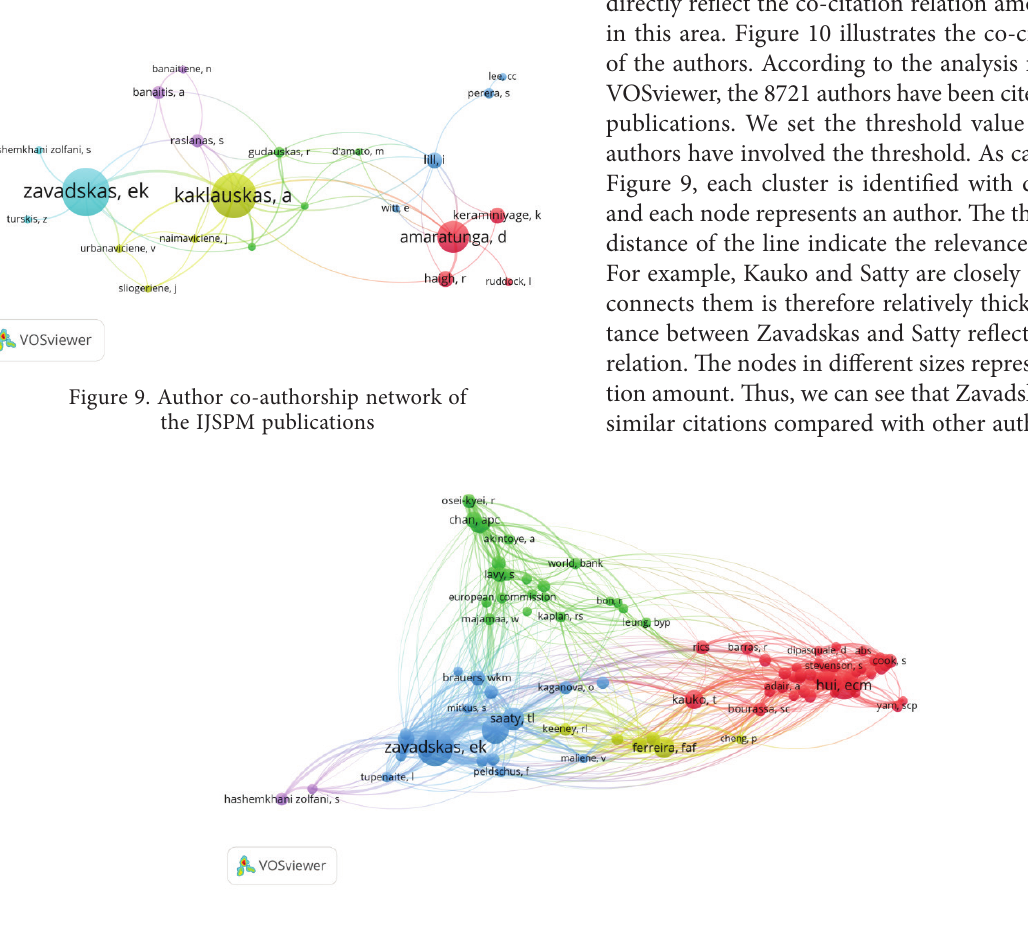
Figure 10. Co-citation network of authors cited by the IJSPM